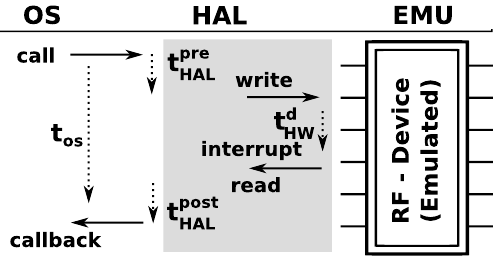
Figure 5. Execution time flow in hardware and